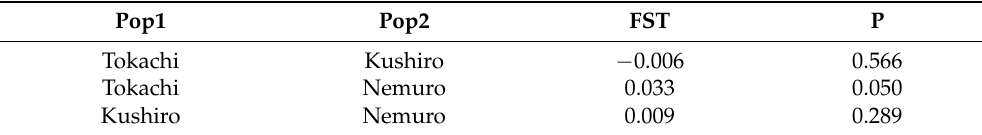
Table 4. Pairwise FST values and corresponding p values from the G-test for genetic differentiation among groups of Tokachi, Kushiro and Nemuro.